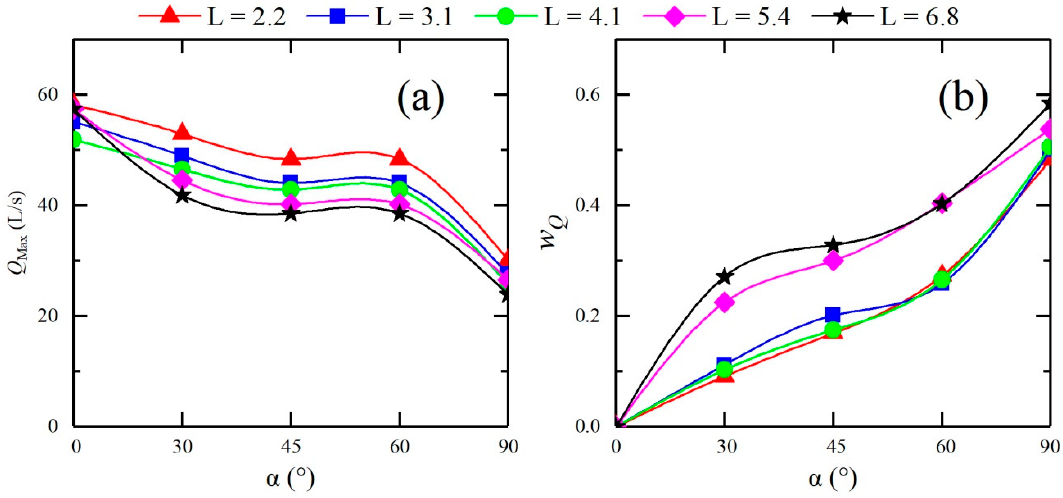
Figure 18. Peak flood discharge and discharge peak reduction factor at different cross-sections in the downstream straight sections of different configurations. ( a ): peak flood discharge; ( b ): discharge peak reduction factor.